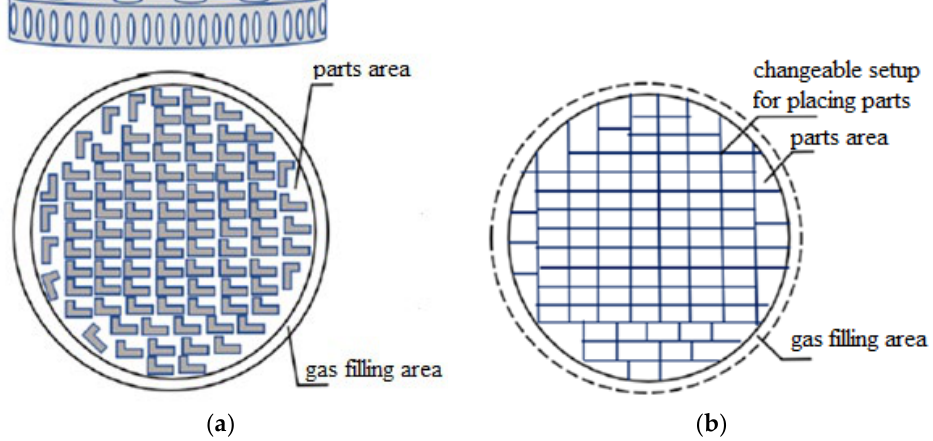
Figure 11. Schematic representation of the rational option for placing parts [3]: ( a ) the base part of the device; ( b ) shift adjustment.